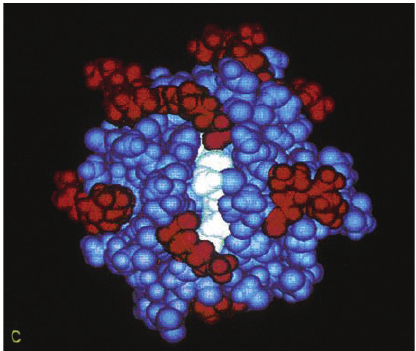
Figure 4: Image depicting cytochrome c which is a small soluble globular protein used in the mitochondrial electron transfer chain that carries electrons as radicals with other mobile transporter carriers ultimately to combine with oxygen and protons to form water [4, 17, 18]. (With permission from the National Institutes of Health/Department of Health and Human